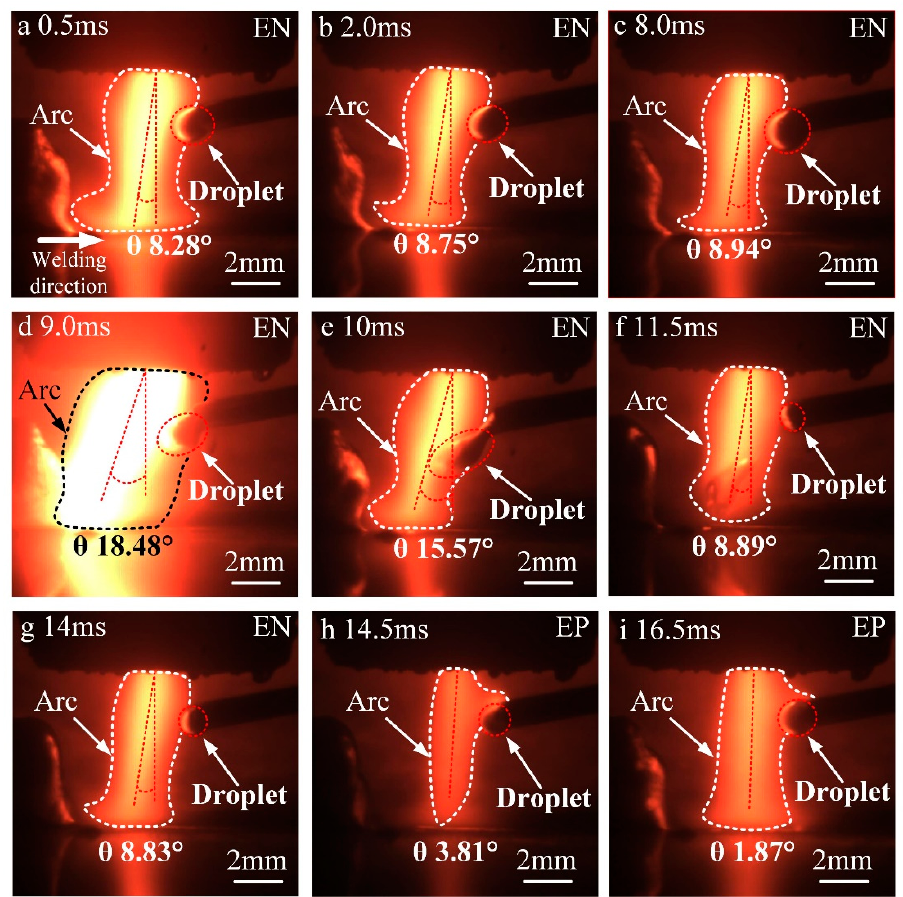
Figure 3. The evolution of the hybrid arc shape and droplet transfer at different times. ( a ) 0.5 ms, ( b ) 2.0 ms, ( c ) 8.0 ms, ( d ) 9.0 ms, ( e ) 10 ms, ( f ) 11.5 ms, ( g ) 14 ms, ( h ) 14.5 ms and ( i ) 16.5 ms.